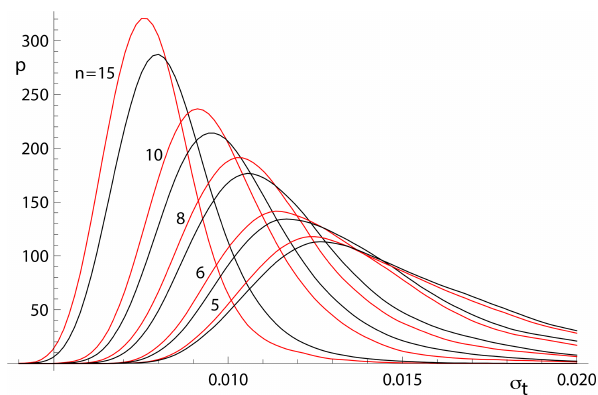
Figure 5. Kernel density estimates for age uncertainty calculated with SPINE on 10000 simulated datasets with a range of n values and Gaussian-distributed uncertainties. In each case, the kde for those datasets for which all | r k | < h is in red and the overall kde is in